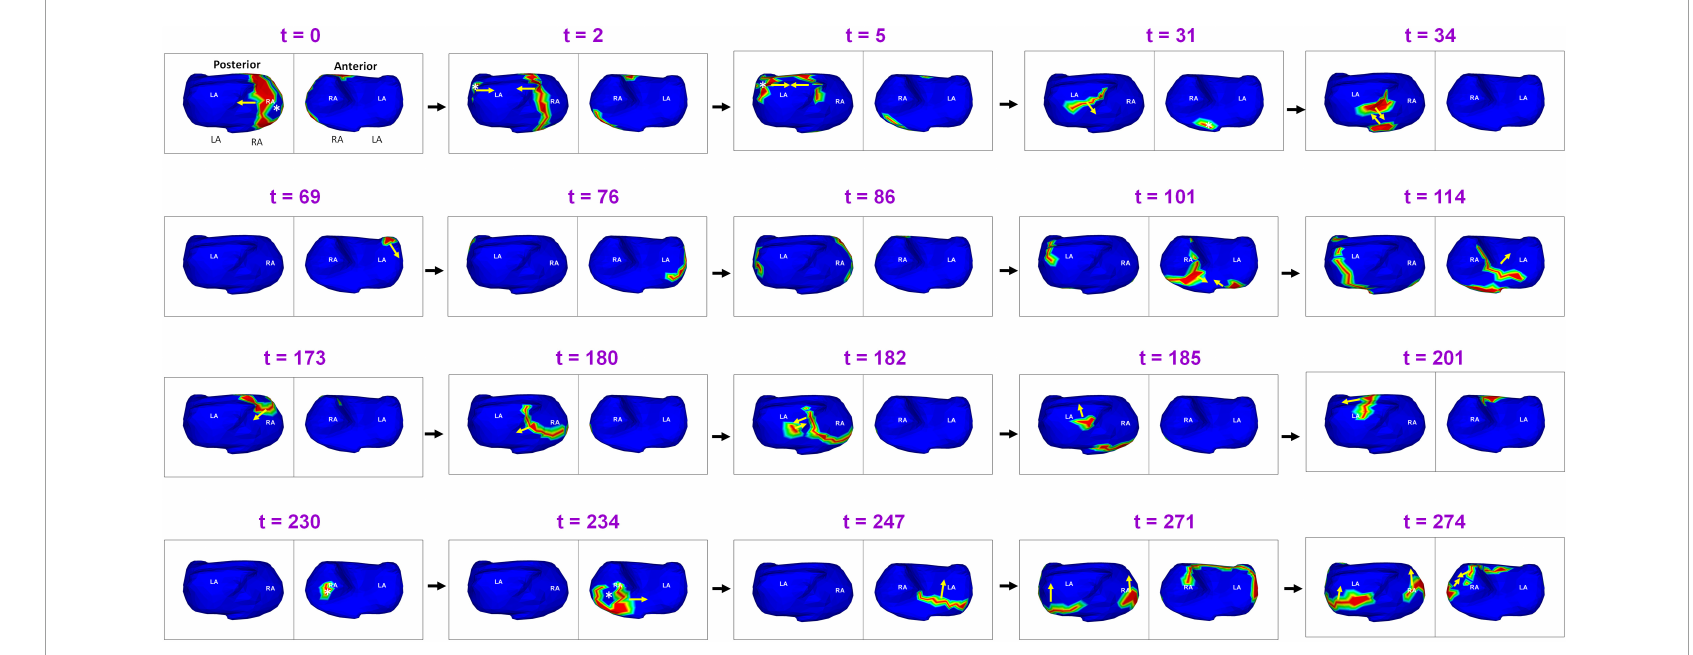
FIGURE5 Complex wavefront activation due to multiple simultaneous wavefronts during pre-ablation persistent AF. The figure shows activity for 274 ms ( Supplementary Video 3